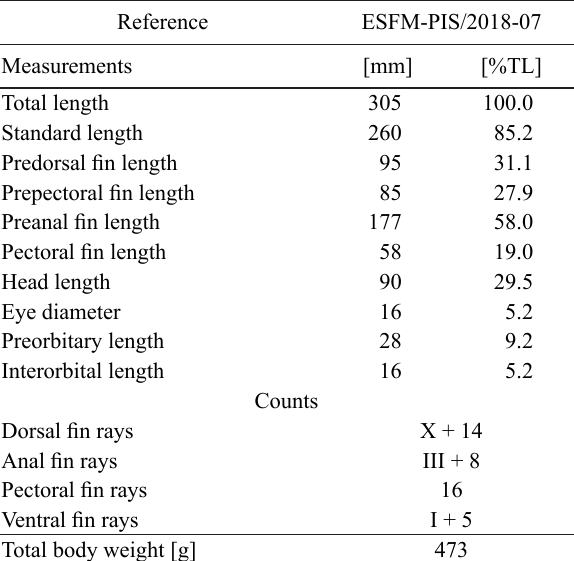
Morphometric measurements in mm and as percentage of total length (%TL) and counts recorded in Lutjanus argentimaculatus , captured from the Gulf of